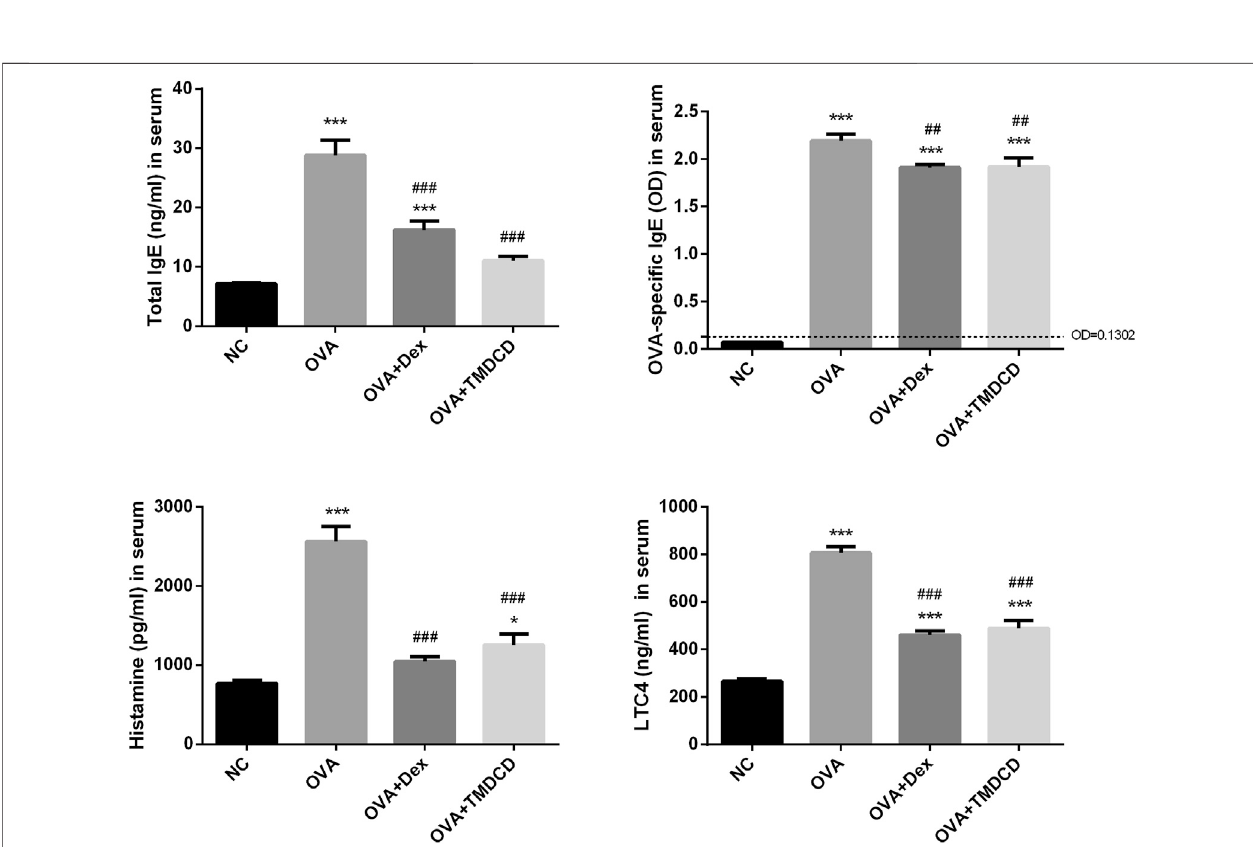
FIGURE 5 | Total IgE, OVA speci fi c IgE, histamine and LTC4 in serum were detected by ELISA. The results were expressed as Mean ± SEM. Compared with NC group, * p < 0.05, *** p < 0.001, compared with OVA group, ## p < 0.01, ### p < 0.001 ( n (cid:2) 5 mice/group).